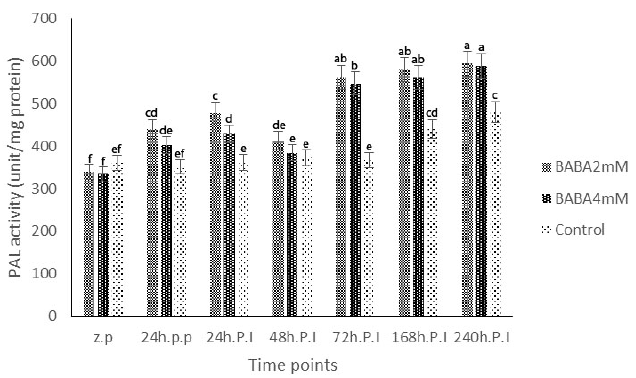
Fig. 8: Effect of BABA pretreatments on Phenylalanine ammonia lyase (PAL) activity. Mean comparison of PAL activity of treated squash plants using Duncan method at a P < 0.01 significance level. Differ- ent letters show significant difference. Z.P; time point 0. 24 PP; 24 h post priming. hpI; hours post inoculation. Standard bar showed dif- ferences at α =